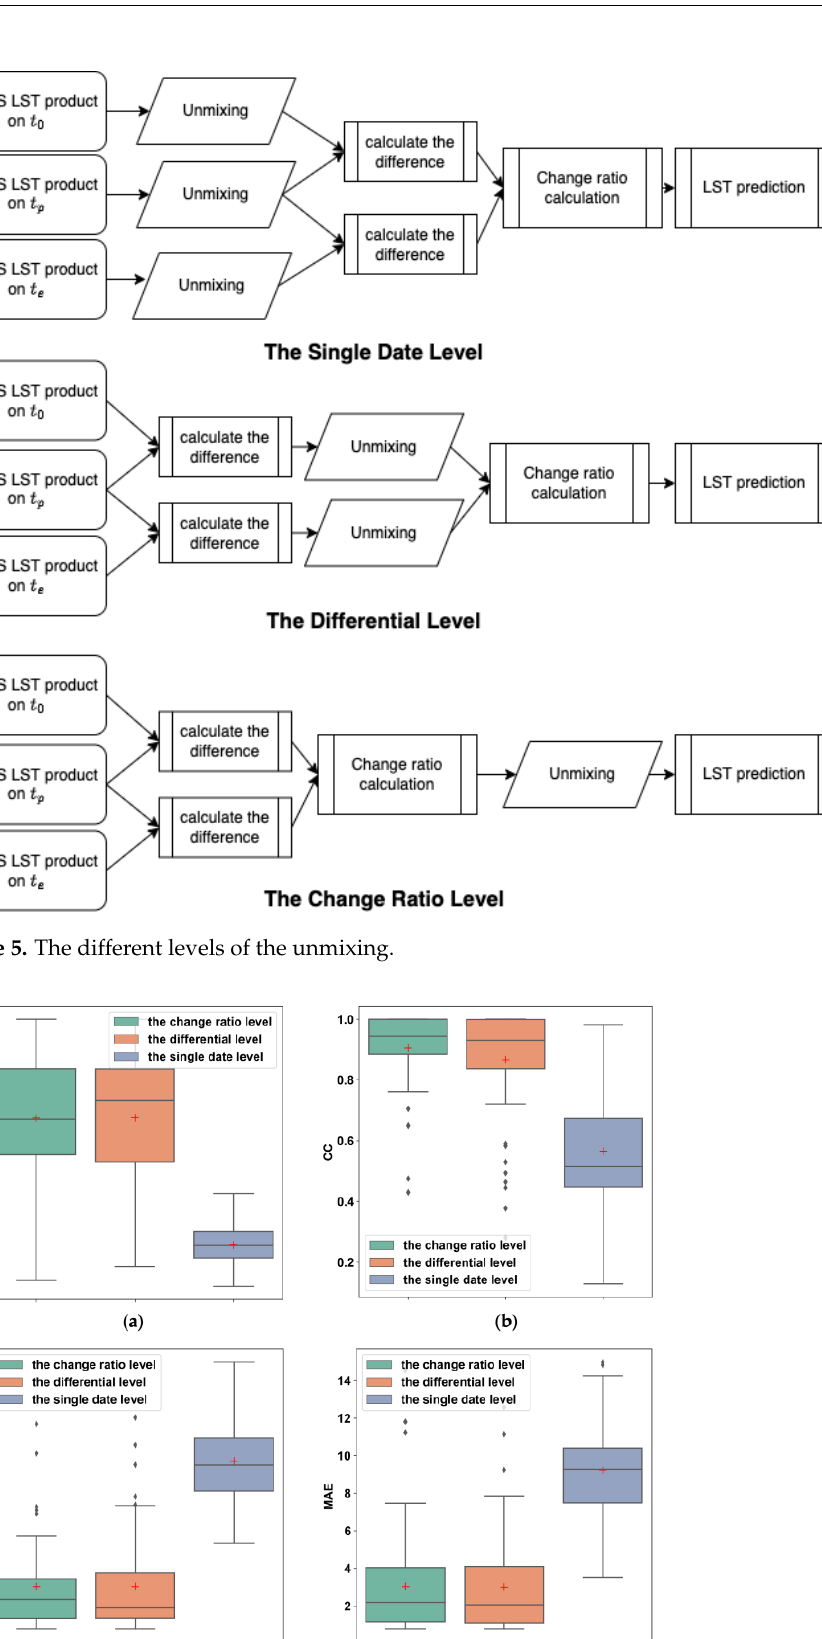
Figure 7. Comparison of the absolute error distribution of model fusion results based on unmixing on the single date level ( a ), the differential level ( b ), and the change ratio level ( c ) on 20 November 2001. 4.3. Analysis of the Effect of the Number of HCRs on Model Stability Theoretically, the finer the HCRs, the more details of LST are obtained. However, when the number of HCRs is larger than the available number of MODIS pixels, it leads to instability in solving the linear unmixing equations. The number of HCRs also affects the accuracy of solving equations by the least squares optimization. Therefore, how to set up the appropriate number of HCRs is crucial to the performance of the model. In this